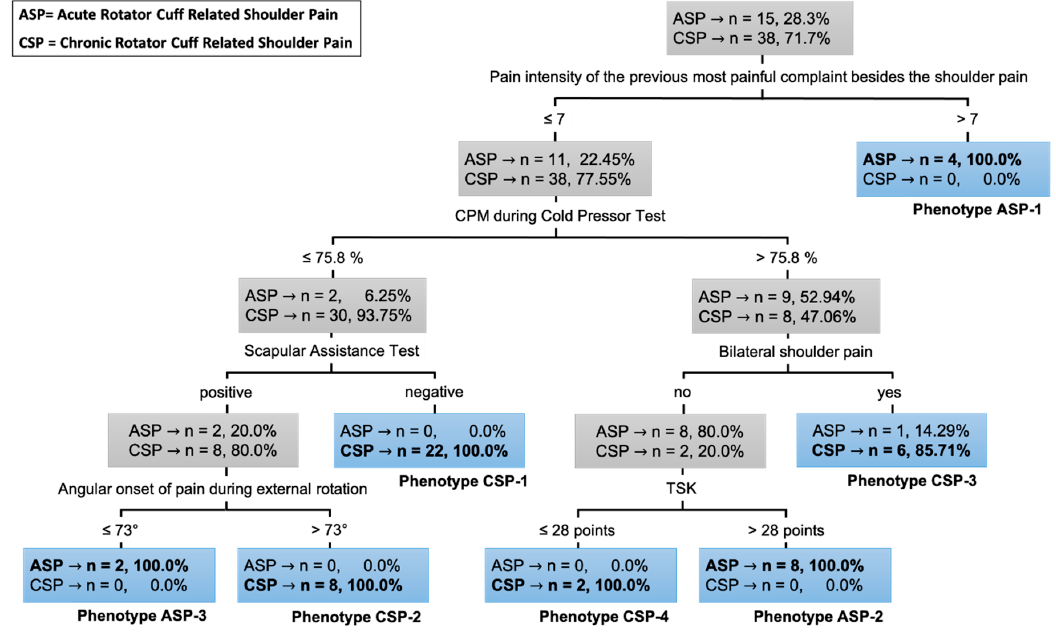
Figure 3. Classification tree model for acute (ASP) and chronic (CSP) rotator cuff related shoulder pain. Abbreviations: CPM—conditioned pain modulation; TSK—Tampa Scale for Kinesiophobia. Abbreviations: CPM—conditioned pain modulation; TSK—Tampa Scale for